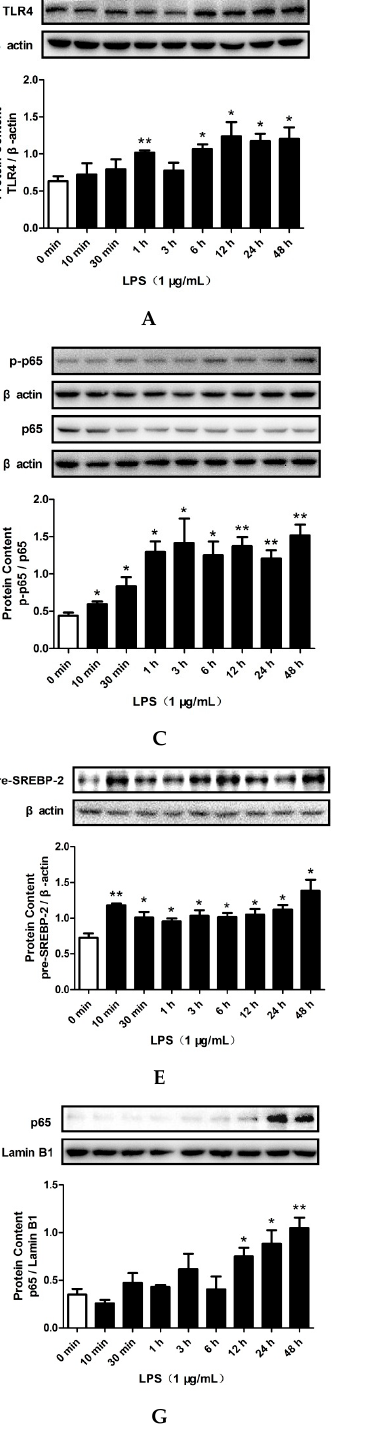
Figure 3. Effects of LPS on TLR4/MyD88/NF- κ B signaling pathway activation and SREBP-2 expression in HepG2 cells. Cells were treated with LPS (1 μ g/mL) for 0 min, 10 min, 30 min, 1 h, 3 h, 6 h, 12 h, 24 h, or 48 h. The total protein levels of TLR4 ( A ), MyD88 ( B ), TNF- α ( D ), SREBP-2 precursor (pre-SREBP-2) ( E ), SREBP-2 mature forms (N-SREBP-2) ( F ), and p65 phosphorylation ( C ) were measured by Western blotting. The nuclear protein levels of p65 ( G ) and N-SREBP-2 ( H ) were detected by Western blotting. The results are presented as means ± SD of three independent experiments; *: p < 0.05 vs. 0 min; **: p < 0.01 vs. 0 min. In addition, Figure S1C shows that PA treatment for 10 min to 48 h did not significantly alter the protein level of TRIF. However, PA treatment significantly increased the protein levels of TLR4 (10 min, 30 min, and 3 h to 48 h), MyD88 (10 min and